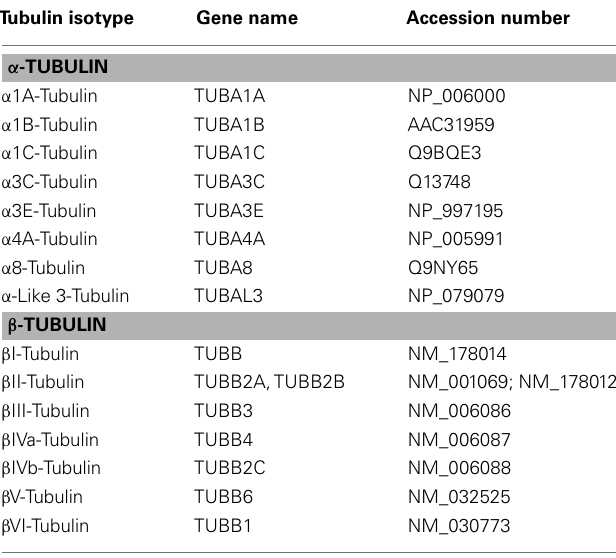
Table 1 |Tubulin isotypes present in humans [Adapted with permission from Macmillan Publishers Ltd: Nature Reviews